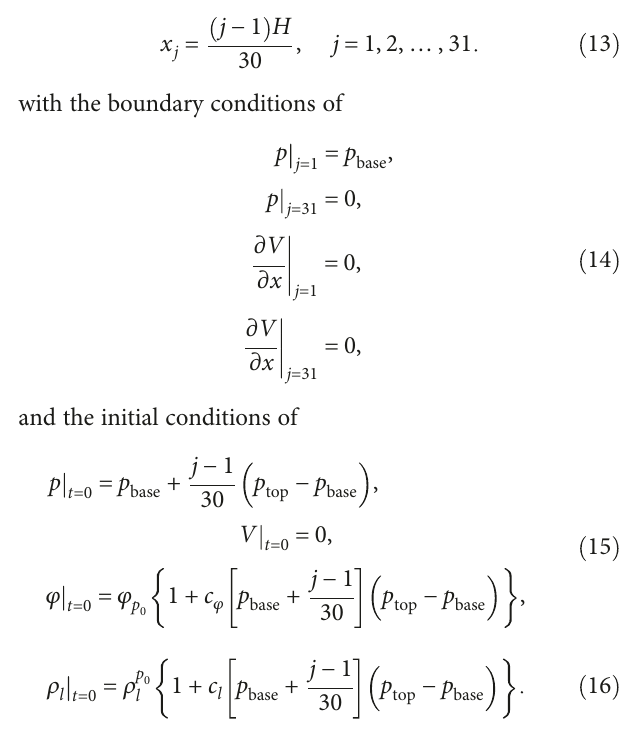
Figure 11: Lagrange unit partition of the actual